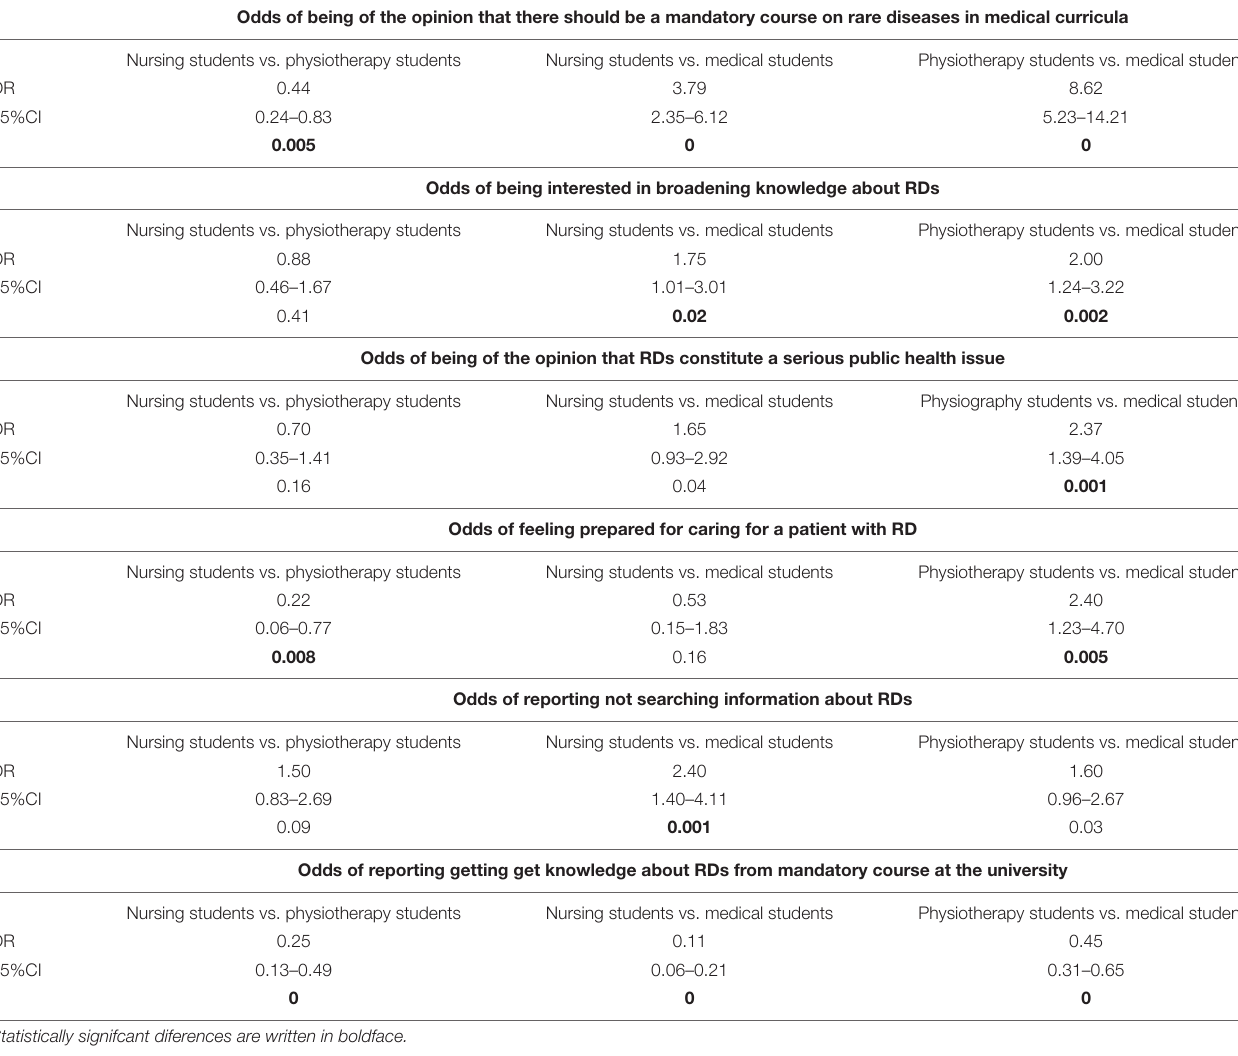
TABLE 6 | The odds ratio of different aspects of nursing, physiotherapy and medical students’ self-assessment. Odds of being of the opinion that there should be a mandatory course on rare diseases in medical curricula Nursing students vs. physiotherapy students